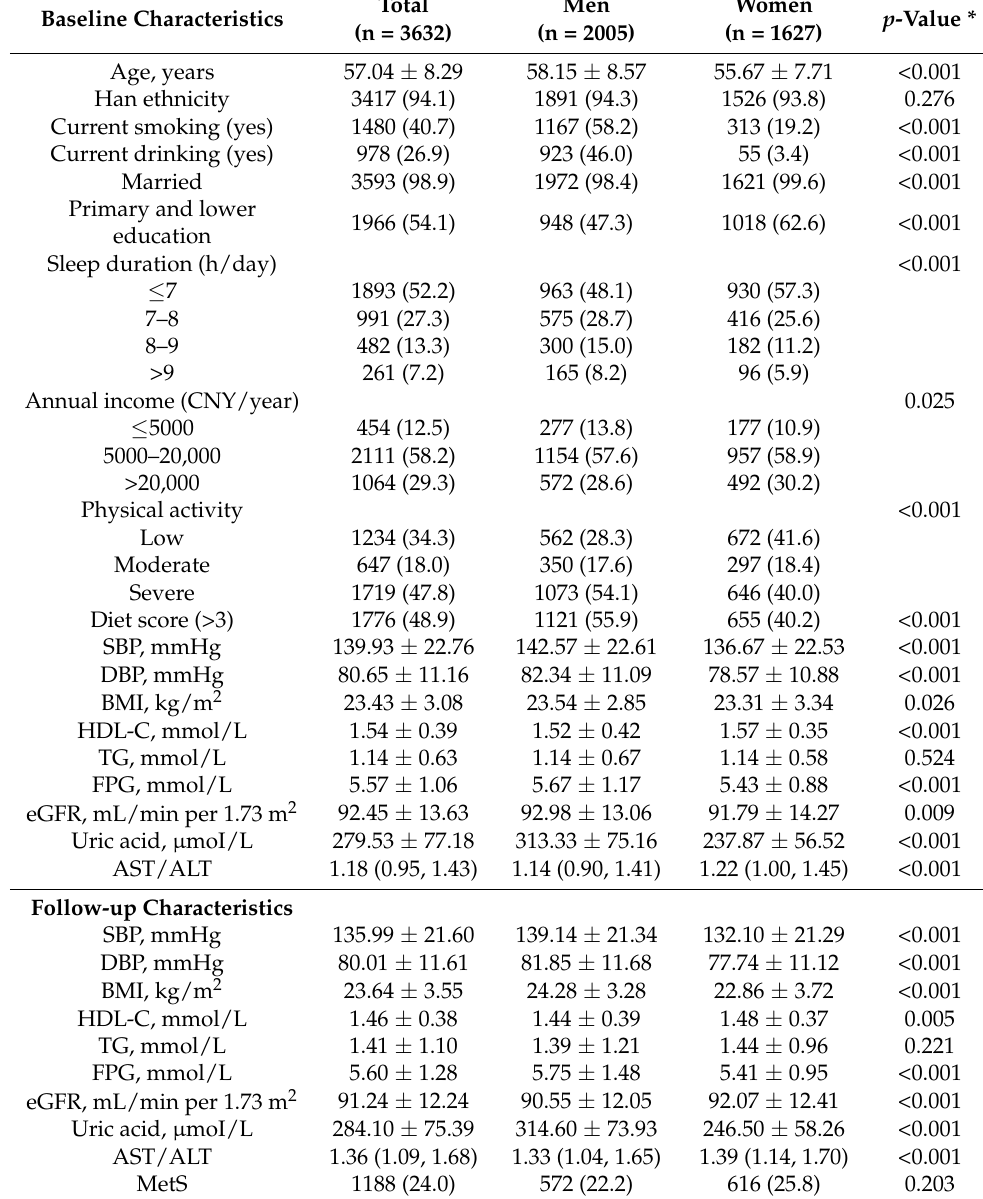
Table 1. Characteristics of study participants according to